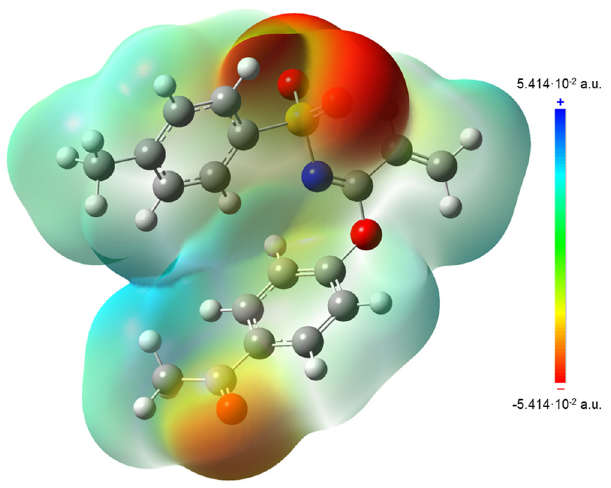
Figure 11. MEP surface (iso-surface 0.0004 a.u.) for 3 calculated at PBE1PBE/cc-pVDZ level of theory.